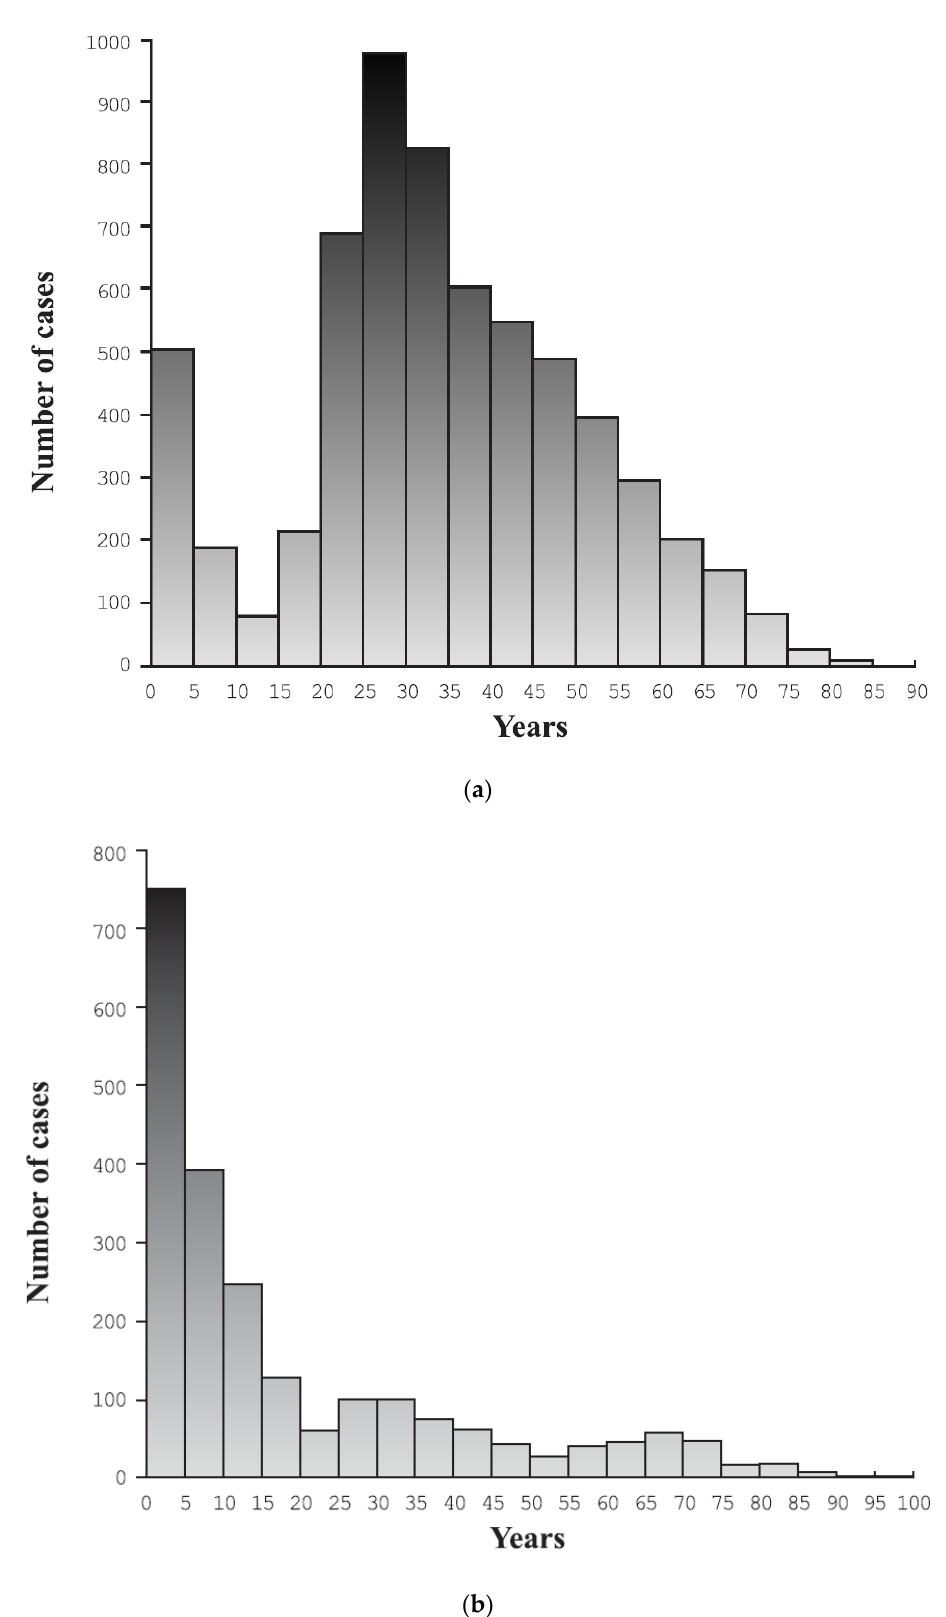
Figure 2. ( a ) Age distribution of Ukrainian patients hospitalized before 24 February 2022. ( b ) Age distribution of Ukrainian patients hospitalized after 24 February 2022.